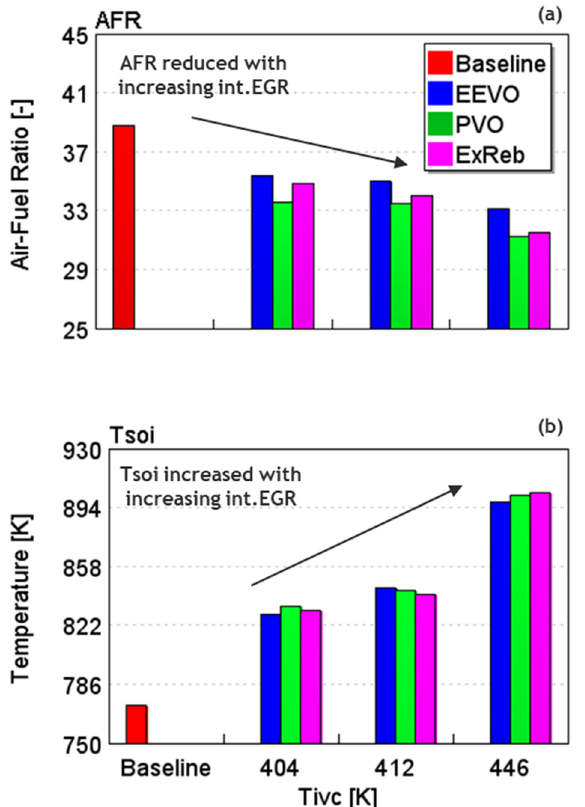
Figure 12. Comparison of ( a ) AFR and ( b ) Tsoi among the EEVO, PVO, and ExReb strategies at different Tivc levels.